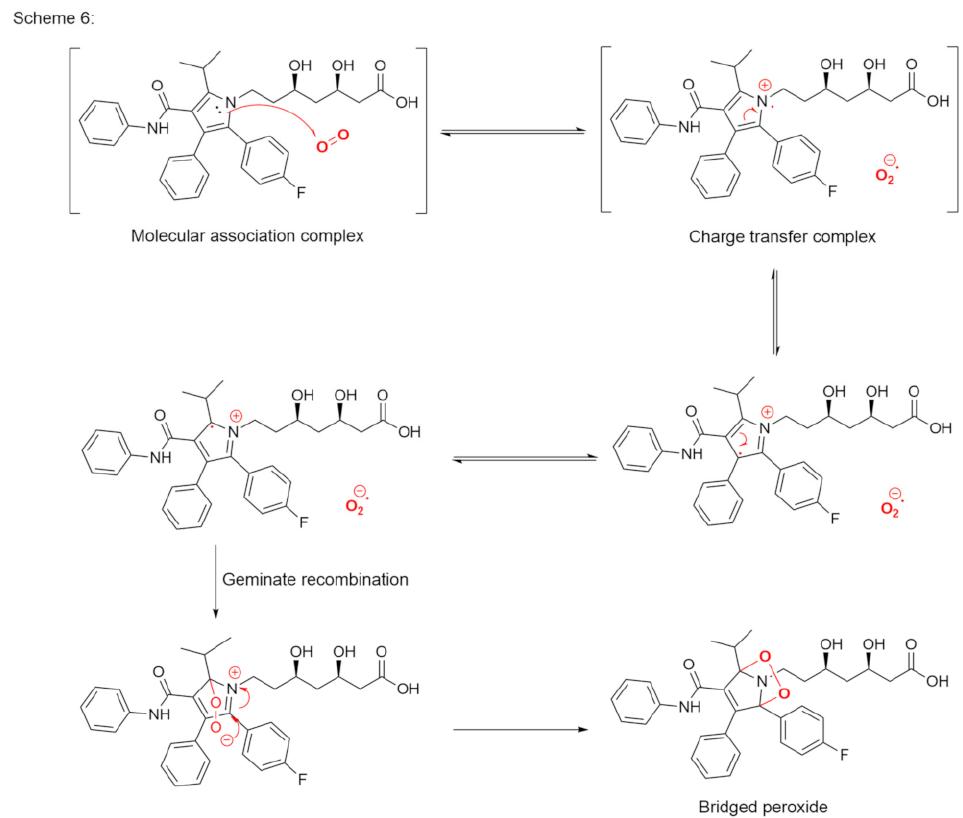
Figure 7. Proposed reaction mechanism for atorvastatin with the formation of a bridged